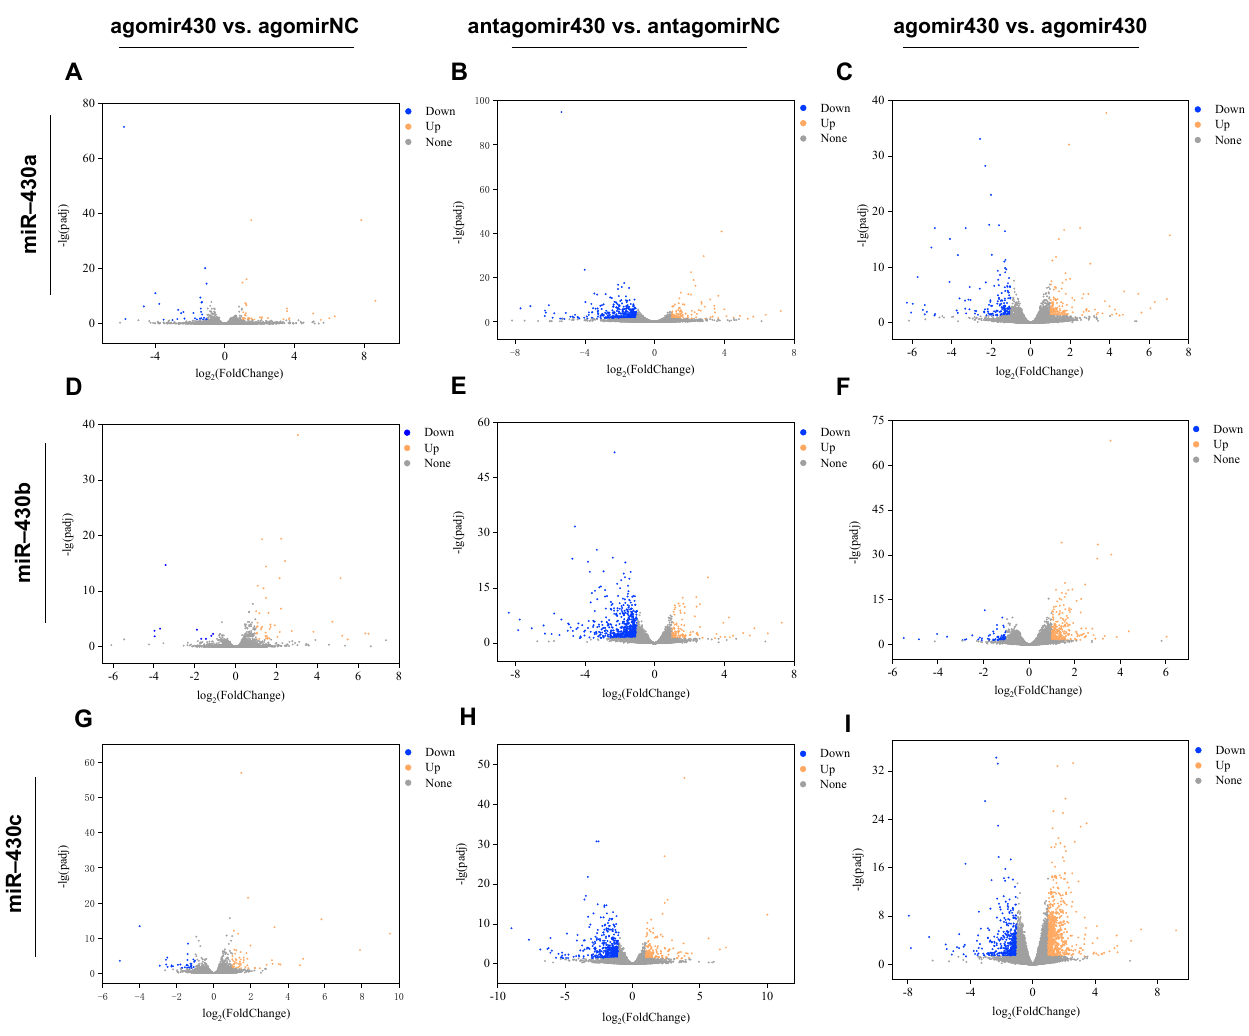
Figure 1. The statistics of DEGs identified in pairwise comparisons. ( A ) The agomir430a group compared with the agomirNC group; ( B ) The antagomir430a group compared with the antagomirNC group; ( C ) The agomir430a group compared with the antagomir430a group; ( D ) The agomir430b group compared with the agomirNC group; ( E ) The antagomir430b group compared with the antagomirNC group; ( F ) The agomir430b group compared with the antagomir430b group; ( G ) The agomir430c group compared with the agomirNC group; ( H ) The antagomir430c group compared with the antagomirNC group; ( I ) The agomir430c group compared with the antagomir430c group. n = 3 for each microinjection group.